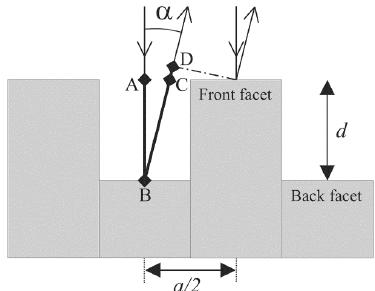
Figure 2. Schematic of a lamellar grating interferometer. (Reprinted with permission from Reference [19] The Optical Society).